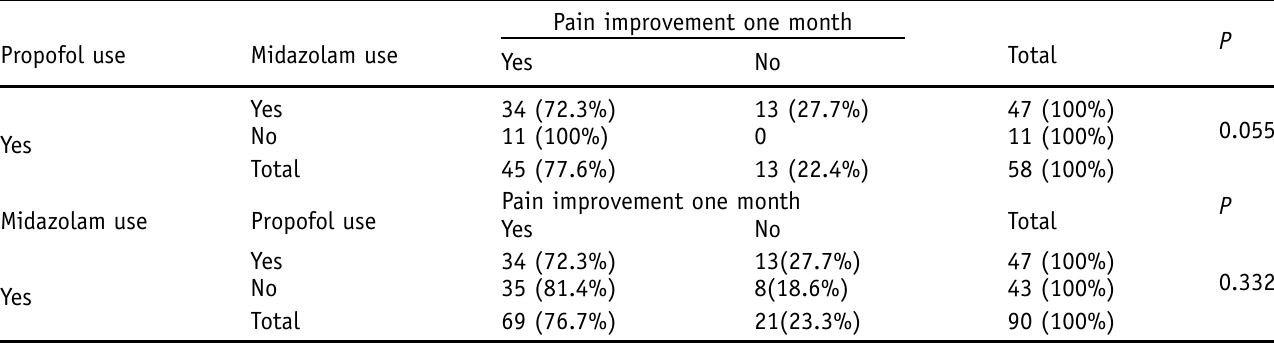
Table II. Relationship between pain improvement and the use of propofol with or without midazolam and the use of midazolam with or without propofol during sedation at one month postarthrocentesis.